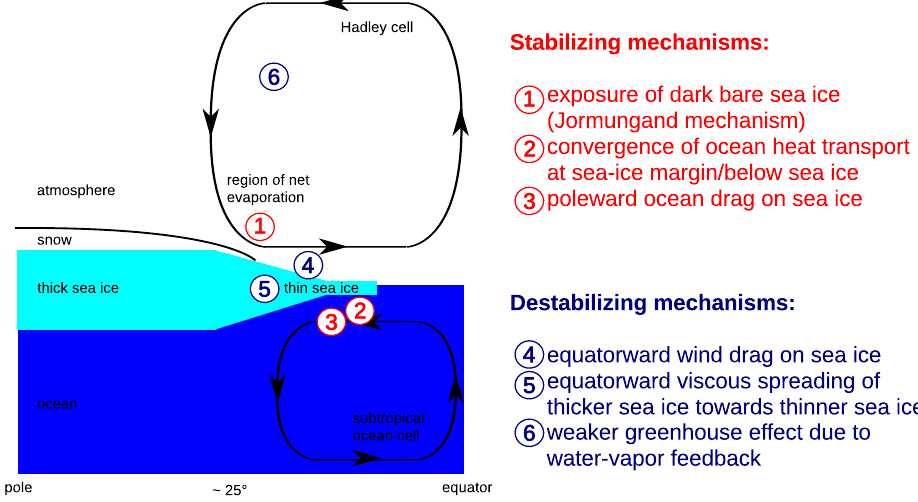
Fig. 13. Schematic illustration of mechanism that stabilize tropical sea-ice margins (red), thereby obstructing Snowball Earth initiation, or destabilize tropical sea-ice margins (blue), thereby promoting Snowball Earth initiation. See text for details. Ultimately, the Snowball Earth bifurcation is caused by the basic ice-albedo feedback (ice and snow reflect more shortwave radiation than land and water). As the figure is meant to illustrate mechanisms that are additional to the basic ice-albedo feedback, the latter is not included.